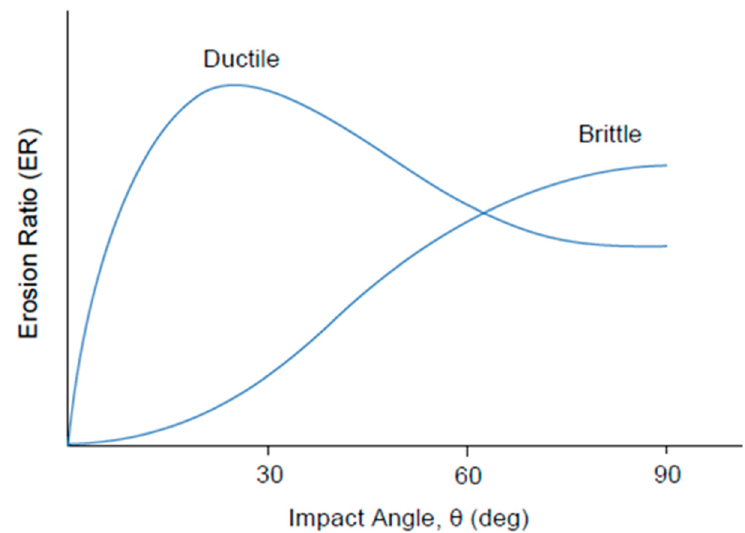
Figure 15. Typical SPE for ductile and brittle materials at different angles of impact. Reproduced with permission from [31]. Elsevier, 2014.